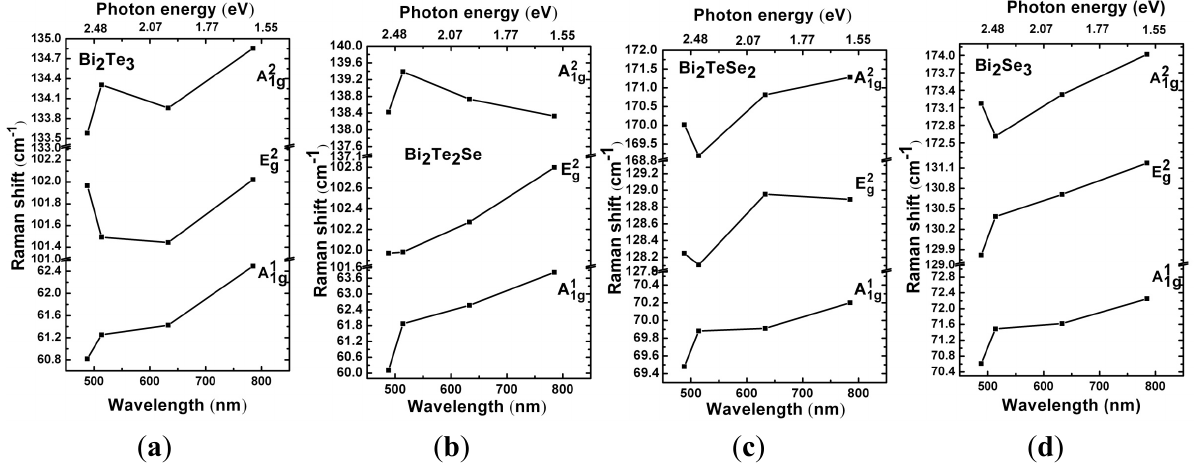
Figure 5. Raman shift of ( a ) Bi 2 Te 3 , ( b ) Bi 2 Te 2 Se, ( c ) Bi 2 TeSe 2 and ( d ) Bi 2 Se 3 under different excitation wavelengths (488, 514, 633 and 785 nm).